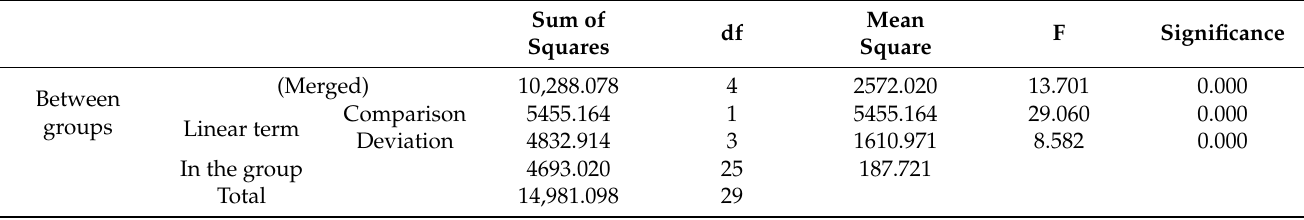
Table 9. Analysis of the variation number when the amount of fertilizer discharged is 0.35 kg/s.